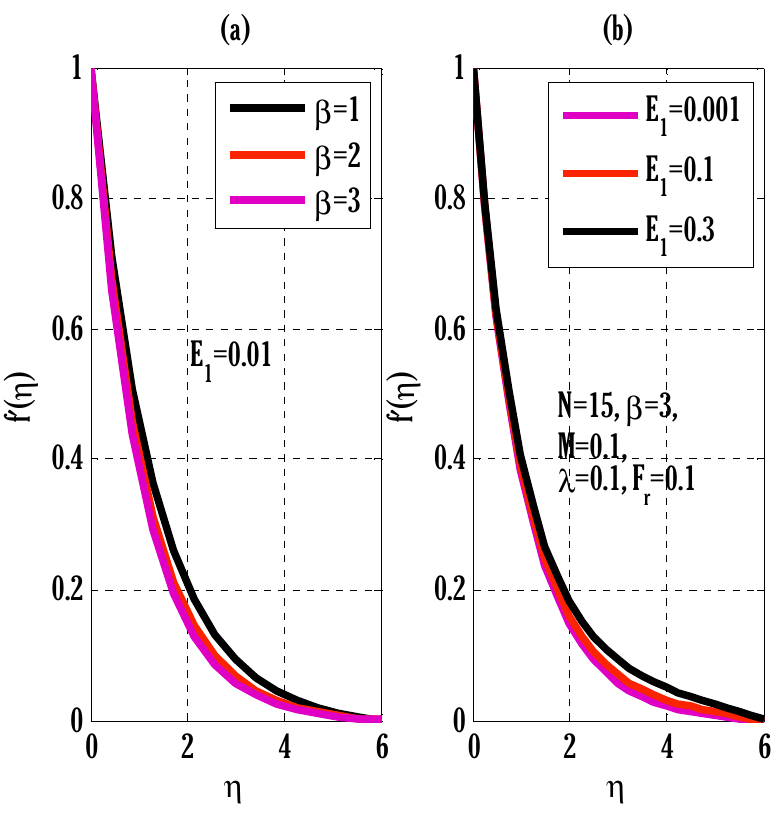
Figure 2. Varia tion of Casson parameter and electric variable on velocity profile using Figure 2. Variation of Casson parameter and electric variable on velocity profile using N = 25, λ = 0.1, F r = 0.1, and M = 0.1. ( a ) E 1 = 0.01, ( b ) β = 𝑁 = 25, 𝜆 = 0.1, 𝐹 = 0.1, and 𝑀 = 0.1. (𝐚) 𝐸 = 0.01, (𝐛) 𝛽 = 3 . (cid:3045) (cid:2869)